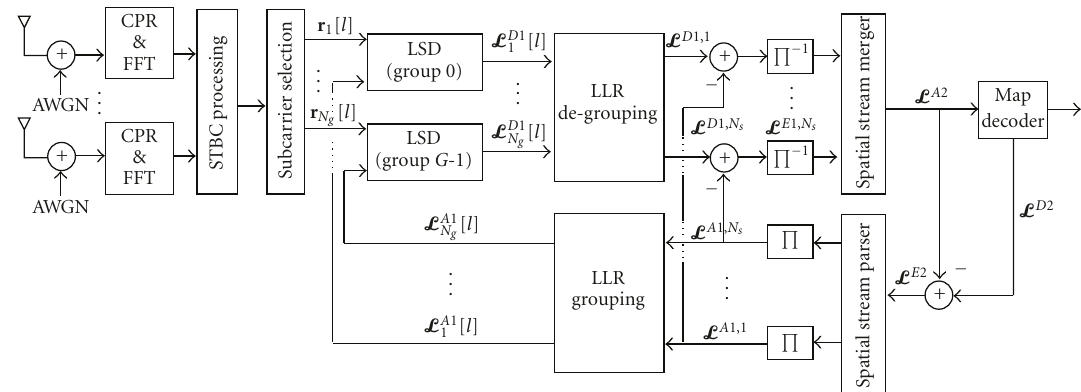
Figure 2: Proposed GO-CDM-enhanced IEEE 802.11n turbo